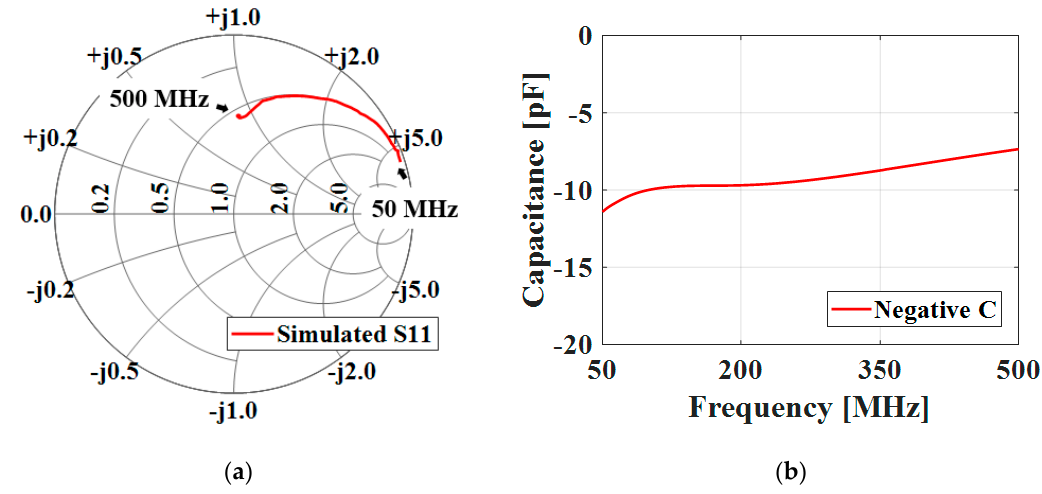
Figure 4. Simulation results of the non-Foster circuit: ( a ) Smith chart of the reflection coe ffi cient. ( b ) Negative capacitance versus